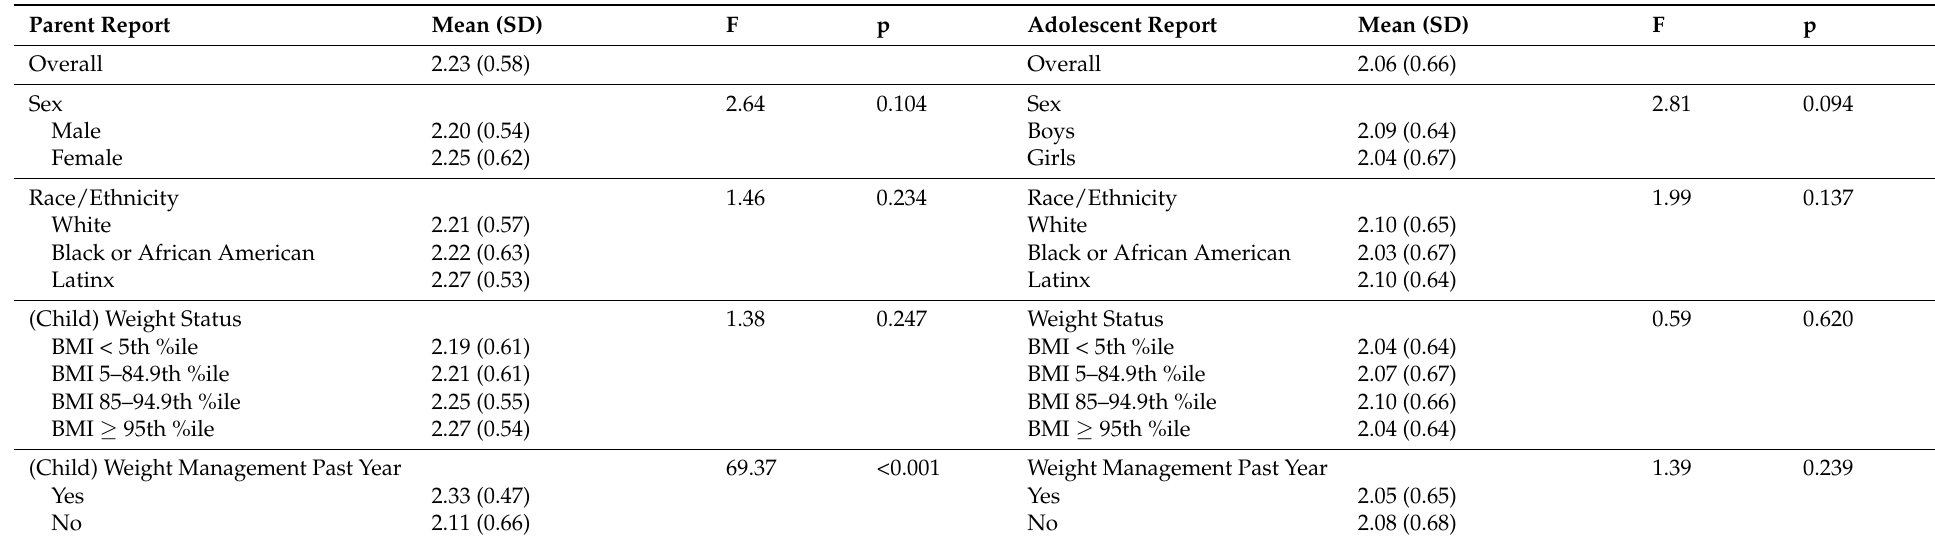
Table 7. Demographic and weight-related differences in parental weight